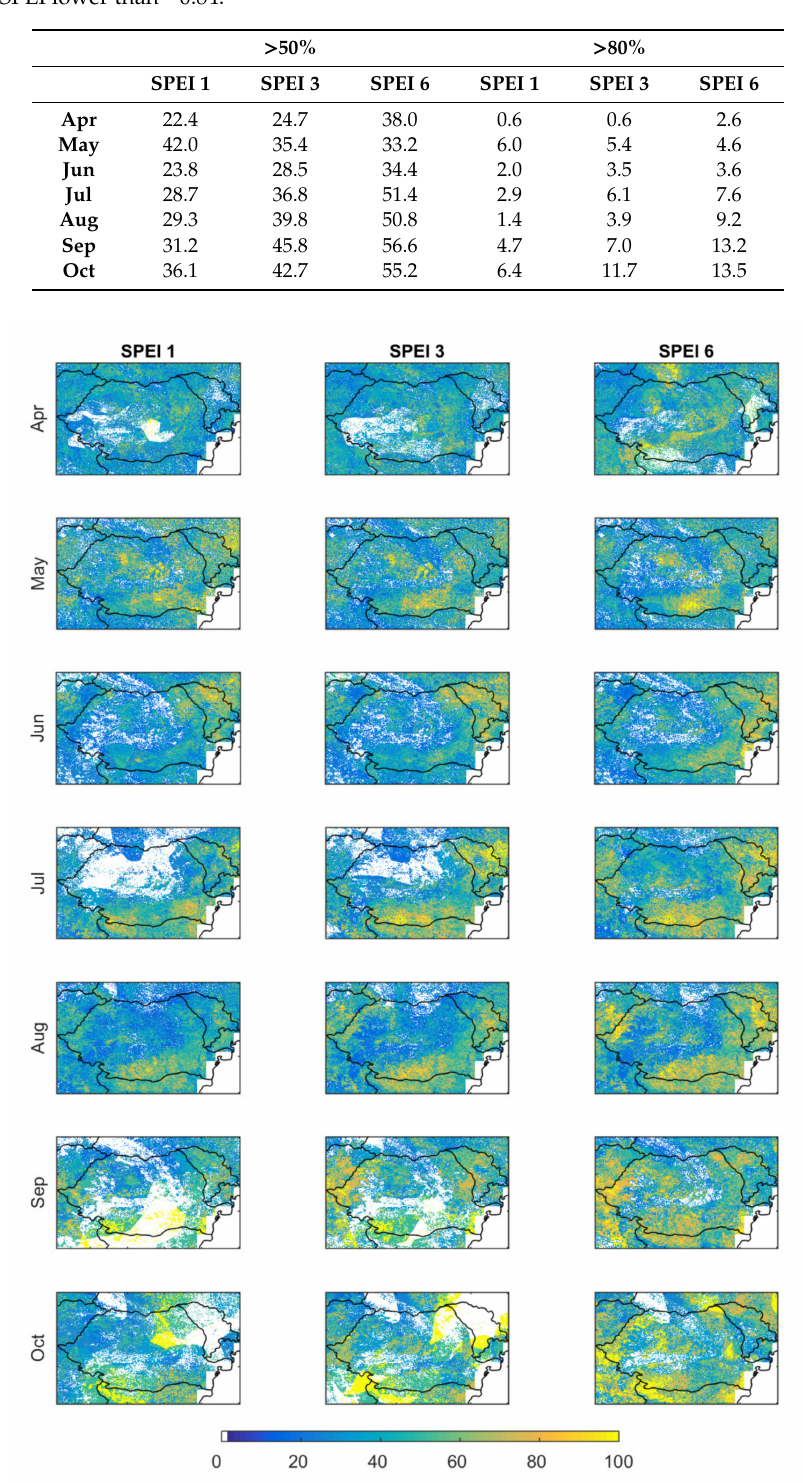
Table 3. Percentage of area showing at least 50% and 80% of simultaneous occurrence of NDVI anomalies lower than − 0.025, and SPEI lower than − 0.84, for the months of April to October and the time scales of 1, 3 and 6 months. The results are shown as a percentage of the number of months showing SPEI lower than − 0.84.